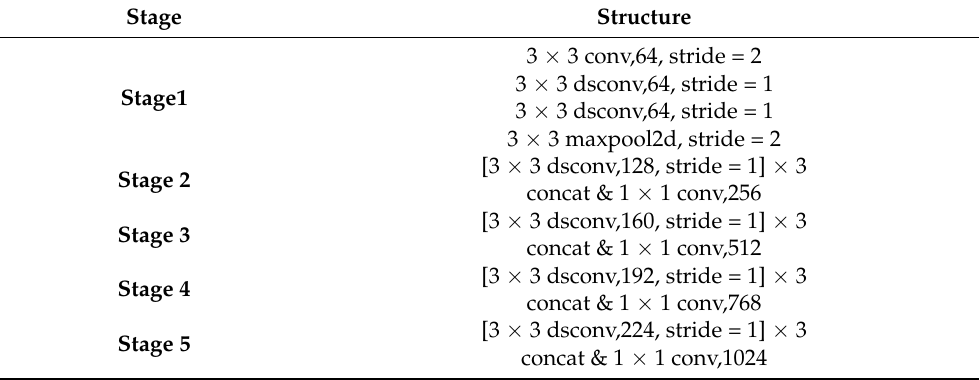
Figure 4. Comparison of different convolutions. Depthwise separable convolutions are special cases of standard convolution. Table 1. An overview of the implementation details of OSADSNet.